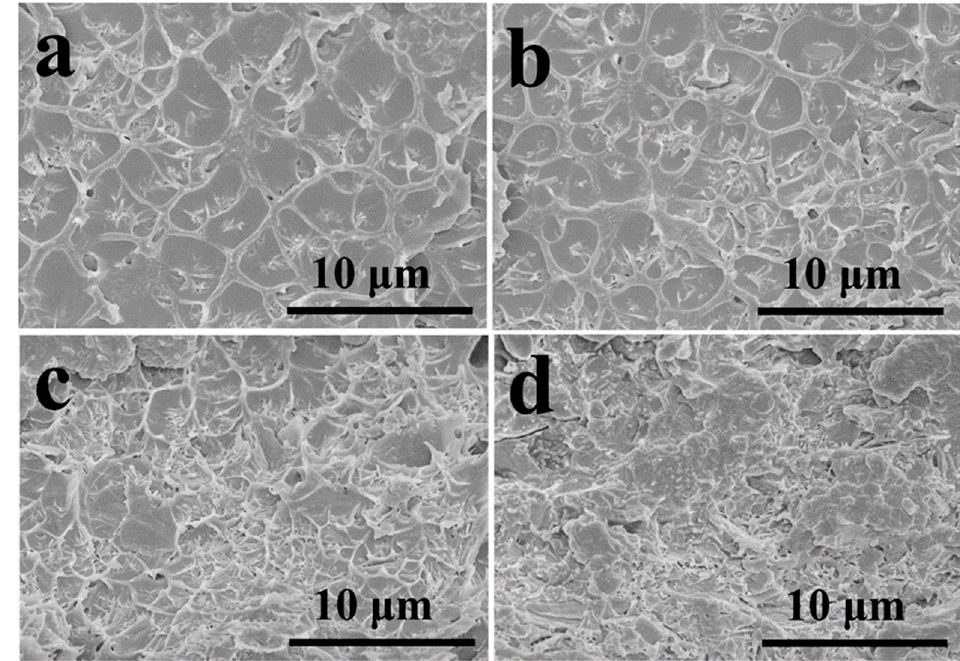
Figure 3. SEM images of SPEEK/DGO/DHNTs composite membranes with DGO/DHNTs (1:1) con- tent of ( a ) 5 wt%, ( b ) 10 wt%, ( c ) 15 wt%, and ( d ) 20 wt%.